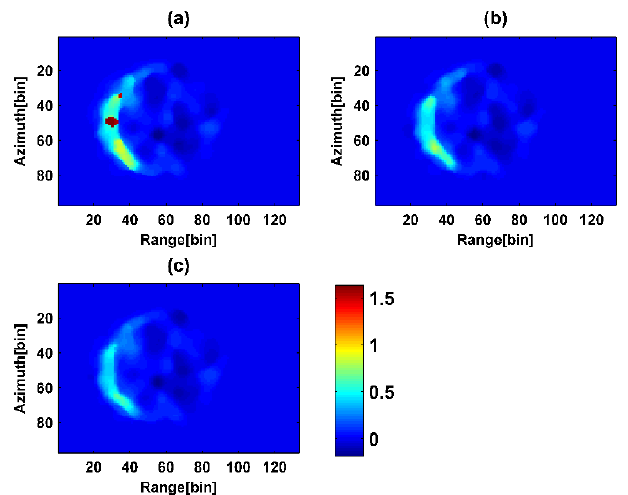
s calculated from complex s